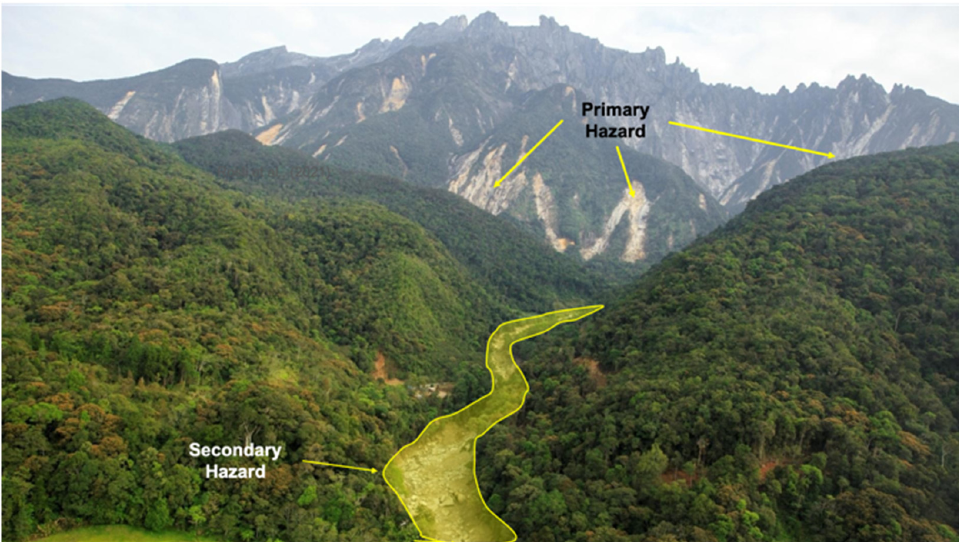
Figure 1. The debris flow (secondary hazard) after the Ranau earthquake (primary hazard) of 2015 at the Mesilau watershed of Kundasang, Sabah.